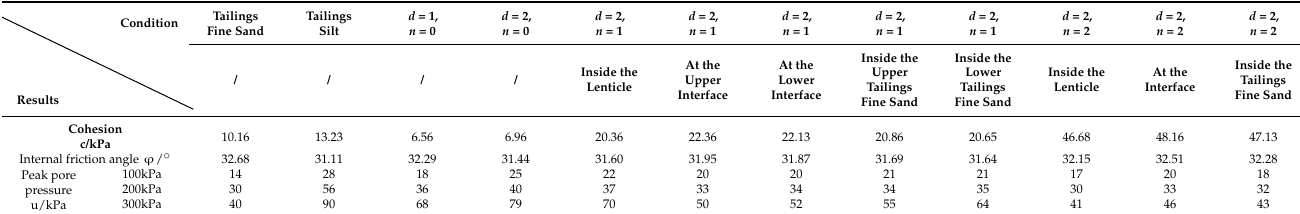
Table 4. The shear strength parameters and peak pore pressure of different